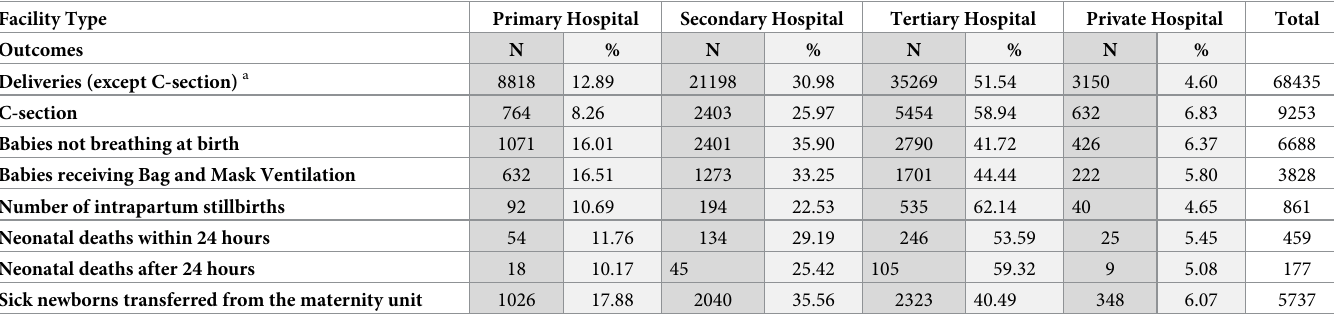
Table 2. Outcomes by facility